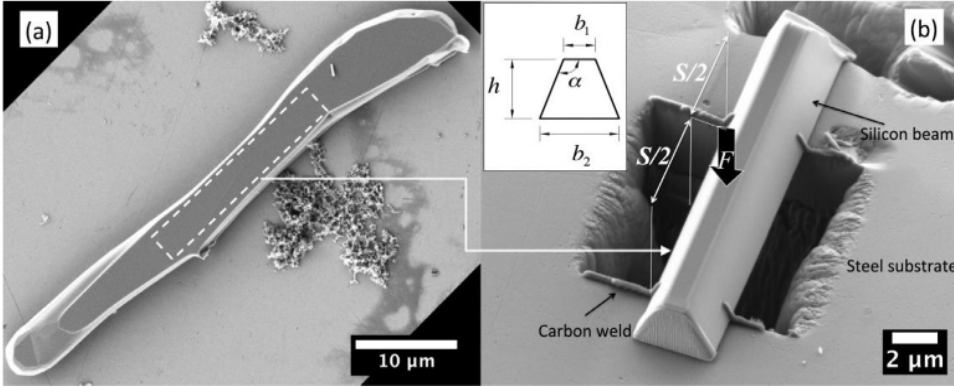
Figure 6. ( a ) Eutectic silicon particle extracted from the Al ‐ Si alloy; ( b ) Microscopic three ‐ point bending specimen prepared from the particle in ( a ), from [37].